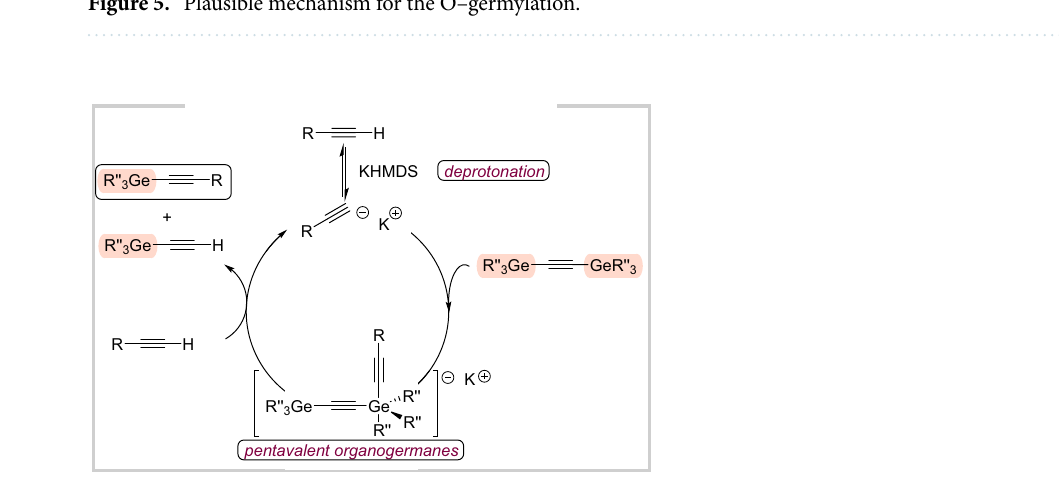
Figure 5. Plausible mechanism for the O–germylation.